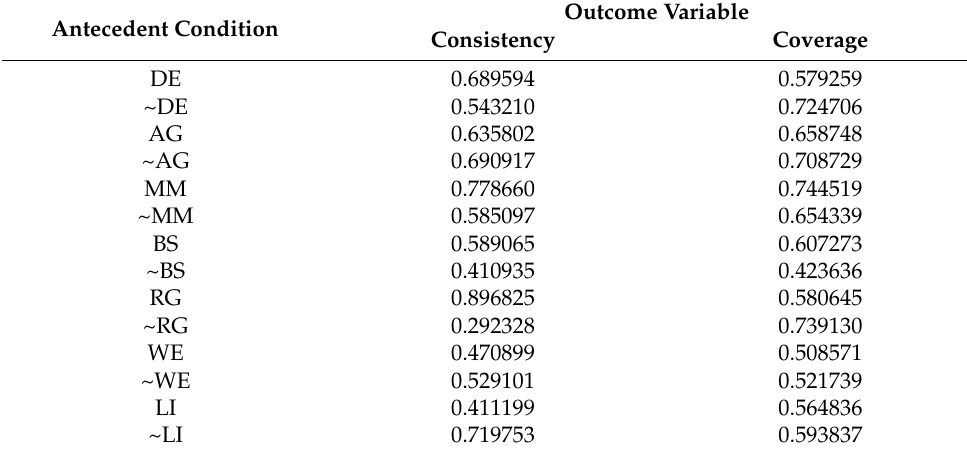
Table 4. Necessity detection of